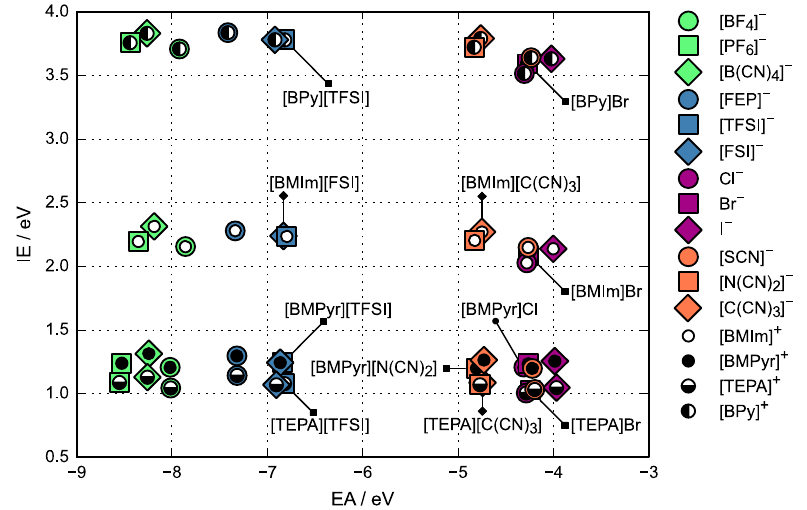
Figure 2. Electron affinities and ionization energies of 48 ionic pairs, determined with the Δ SCF method. Each of the inner circles indicates a cation and the surrounding marker indicates an anion of an ionic pair.